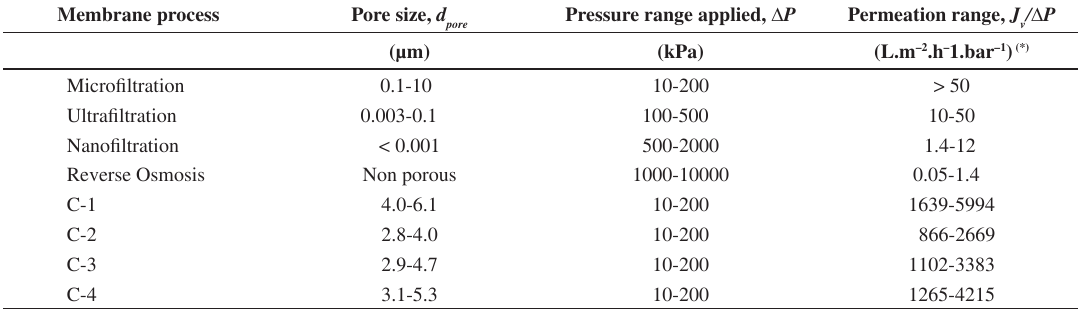
Table 5. Typical permeation ranges employed in membrane filtration and estimated values for ceramic compositions C-1 to C-4. Membrane process Pore size, d